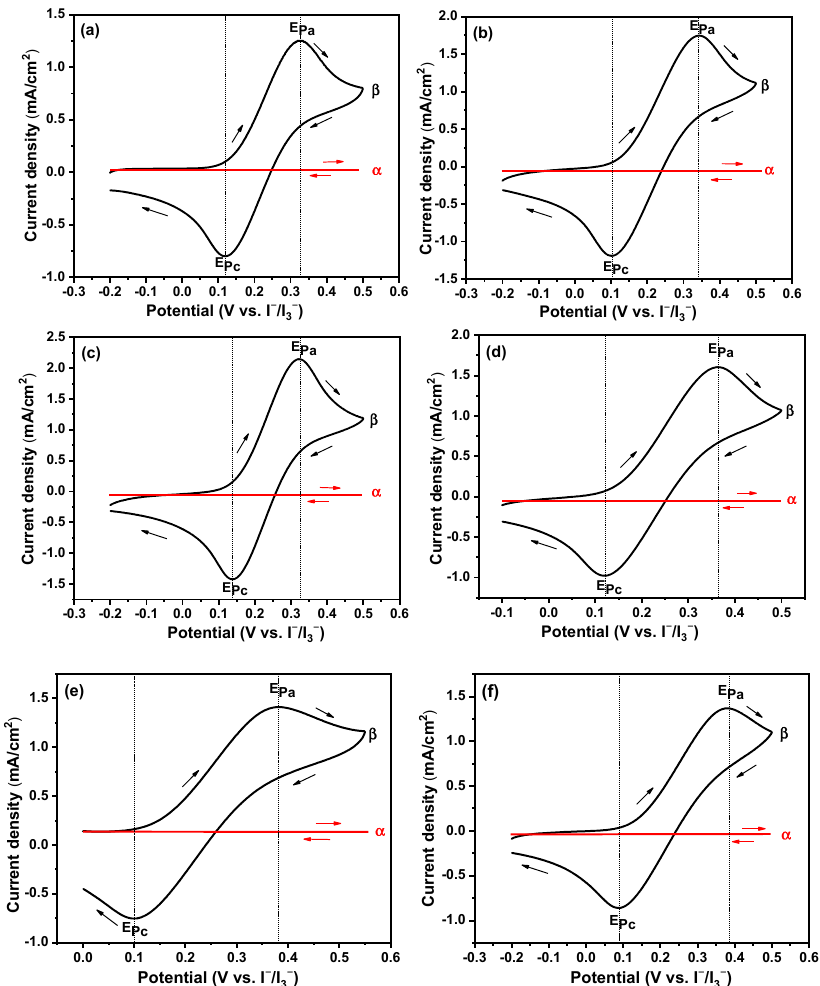
Figure 1. Cyclic voltammetry measured in [Emim]BF 4 /PC ( a ), [Bmim]BF 4 /PC ( b ) [Hmim]BF 4 /PC ( c ), [Omim]BF 4 /PC ( d ), [Dmim]BF 4 /PC ( e ), [Bu 4 N]BF 4 /PC ( f ); α : blank, β : 10 mM ferrocene; [Emim]BF 4 : 1-ethyl-3-methylimidazolium tetrafluoroborate; [Bmim]BF 4 : 1-butyl-3-methylimidazolium tetrafluoroborate; [Hmim]BF 4 : 1-hexyl-3-methylimidazolium tetrafluoroborate; [Omim]BF 4 : 1-octyl-3- methylimidazolium tetrafluoroborate; [Dmim]BF 4 : 1-decyl-3-methylimidazolium tetrafluoroborate; and [Bu 4 N]BF 4 : tetrabutylammonium